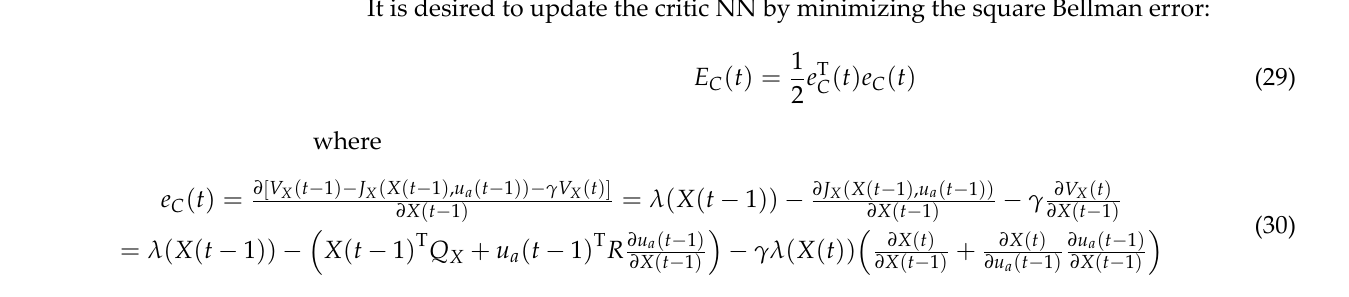
Figure 3. The critic NN and actor NN.